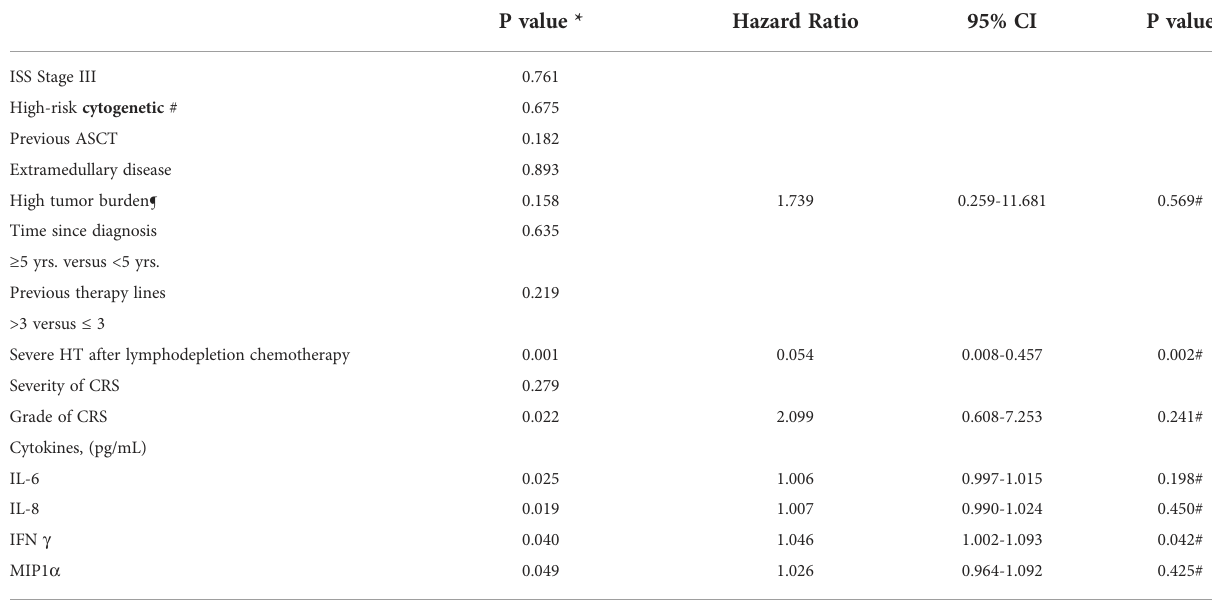
TABLE 3 Factors related to PHT.